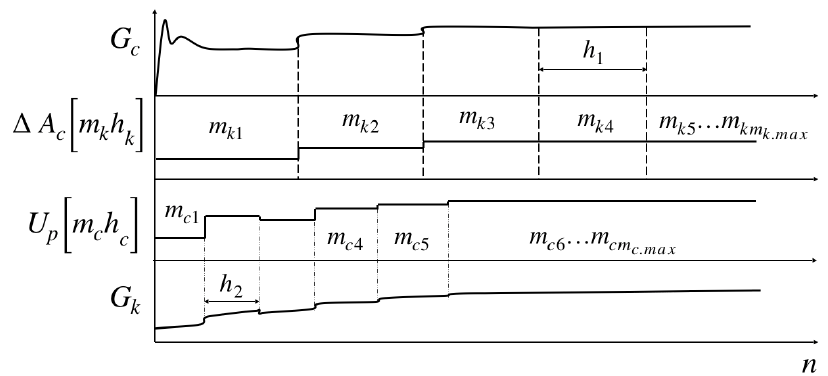
Figure 6. Function of the G c and G k correction at the ends of the structure’s constancy intervals.